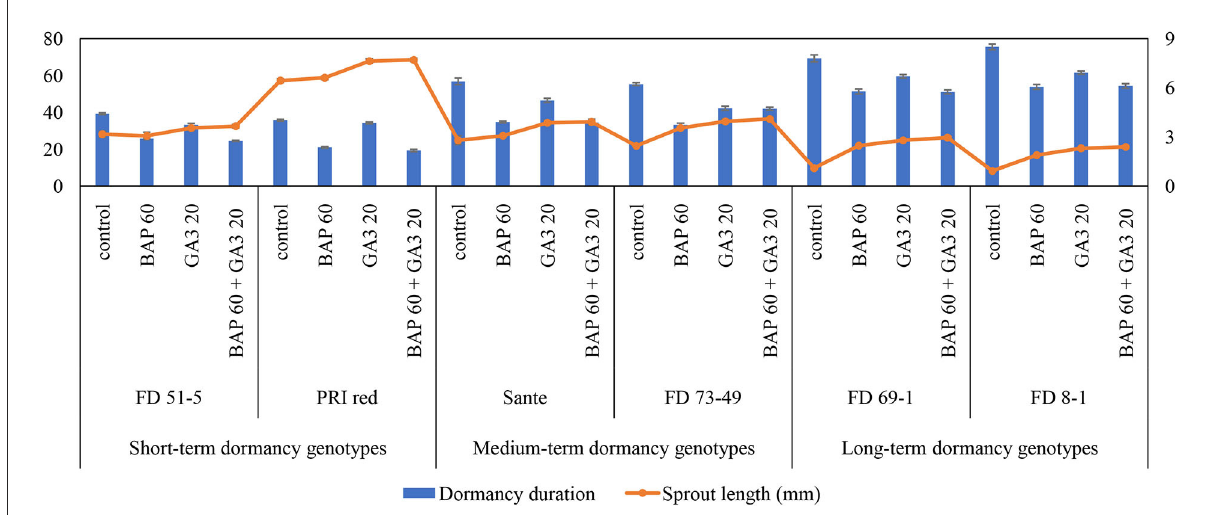
FIGURE3 Mean comparison of dormancy duration (days) and sprout length (mm) in potato tubers under genotype × PGR interactive effect. Vertical error bars represent standard error of means.